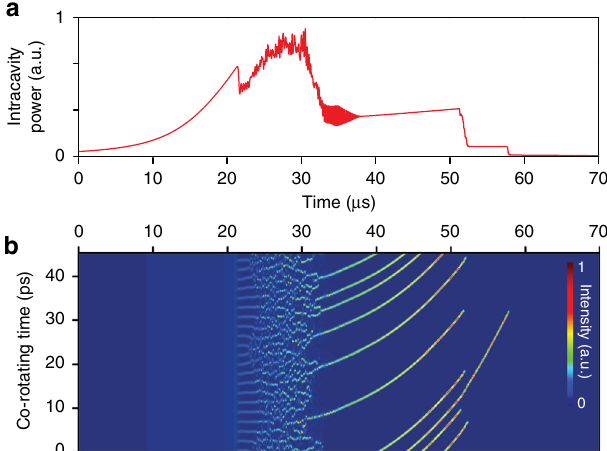
Fig. 5 Simulation of multiple microcavity soliton formation and their trajectories. a Simulated intracavity power plotted versus time as the pumping laser is tuned across a cavity resonance from higher to lower frequencies. The step features correspond to the formation of solitons. b Simulation results corresponding to panel a and showing the formation of multiple solitons. In the simulation, the Raman effect and avoided mode crossing are included